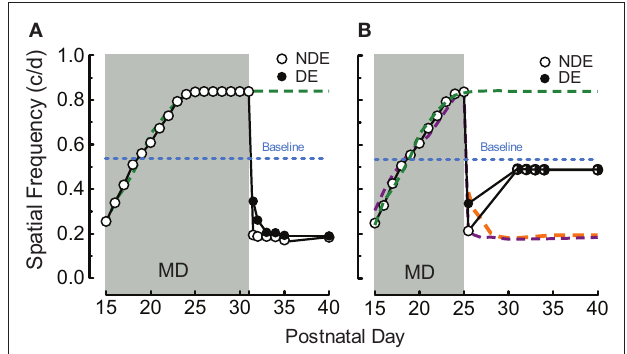
Figure 2 | Juvenile experience consolidates loss-of-function. (A) OKT experience after P25 was not sufficient to consolidate enhancement through the NDE (as binocular testing does; i.e., Prusky et al., 2008) and prevent loss-of-function (green and blue traces from Figure 1A ). (B) Binocular OKT experience after P15–P25 MD was necessary to maintain loss-of-function (as in Figure 1B ), since thresholds returned to near baseline when OKT testing was suspended from P25